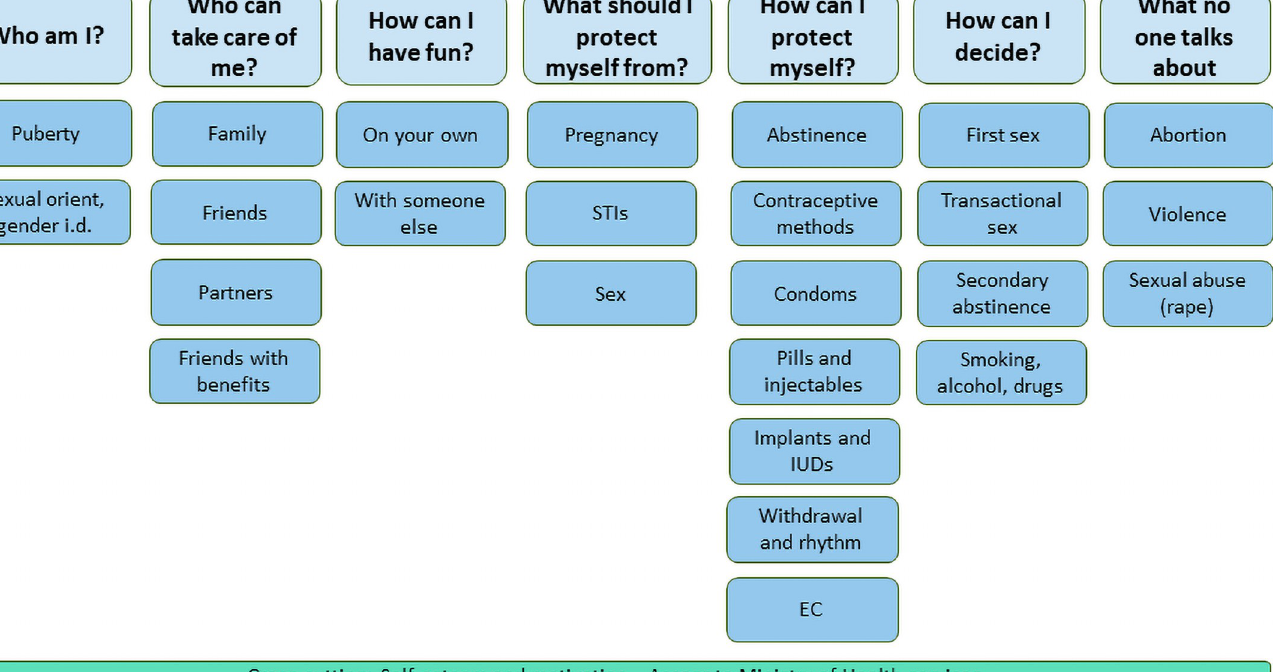
PLOS ONE | https://doi.org/10.1371/journal.pone.0262986 February 10,